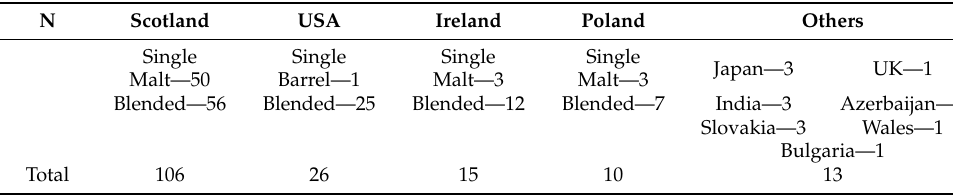
Table 1. Characteristics of the tested set of